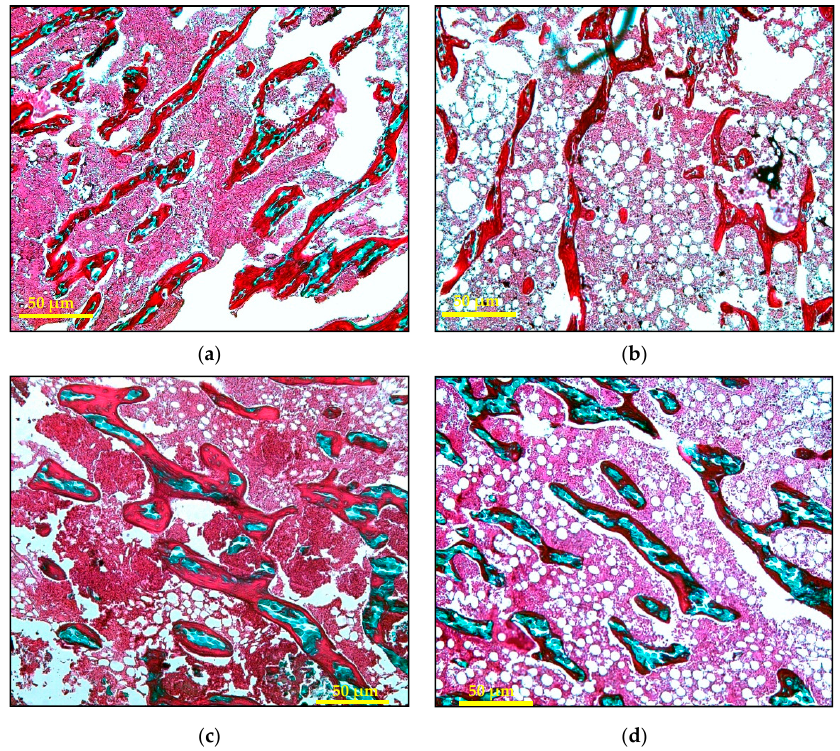
Figure 2. Photomicrograph of decalcified trabecular bones for static histomorphometry parameters using Masson–Goldner Trichrome staining (50X magnification): ( a ) Sham; ( b ) AC: Adrx control